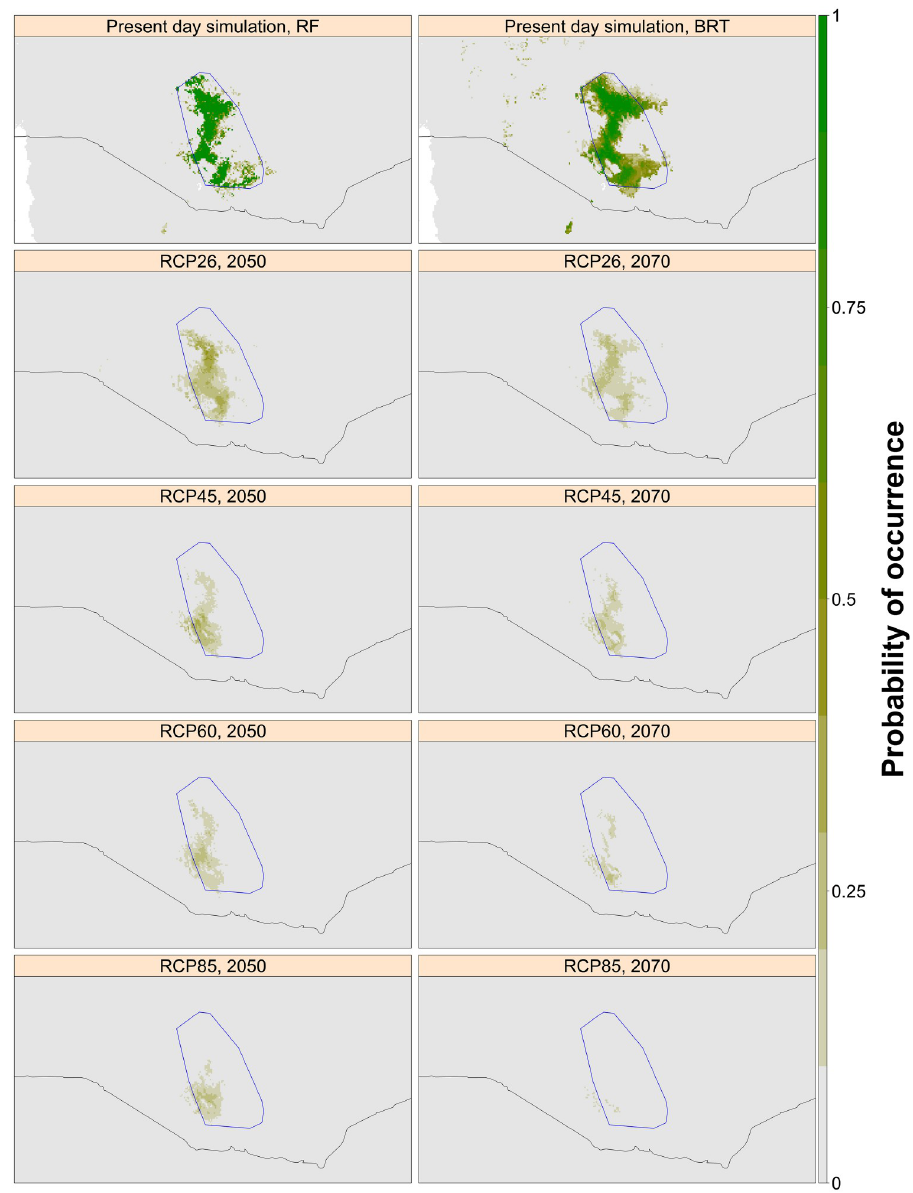
Fig 6. Projected current and future potential range for the Ethiopian Bush-crow based on climate-only SDMs. Predictions for the four IPCC RCPs are presented for two future dates, 2050 and 2070. Each panel represents the mean probability of occurrence under each scenario, averaged across six GCMs and the two best-performing model algorithms (BRT and RF) under current conditions, according to k -fold LOOCV AUC. Dark green shows areas with a high probability of climatic suitability, fading through brown to grey, which shows areas with a low probability of climatic suitability. The blue polygon shows the convex hull fitted around the bush-crow’s current distribution. International borders are plotted using the ‘ wrld_simpl ’ dataset available in the ‘ maptools ’ package in R [47,